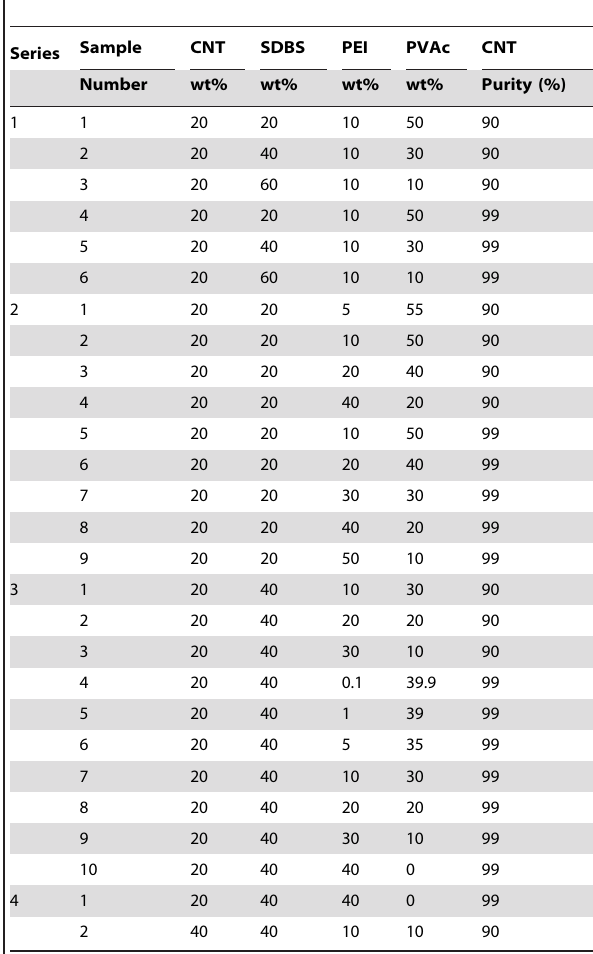
The samples were divided into four different series in order to identify the influence of the SDBS concentration (Series 1), the PEI concentration (Series 2 and 3), and air stability (Series 4) on the electrical